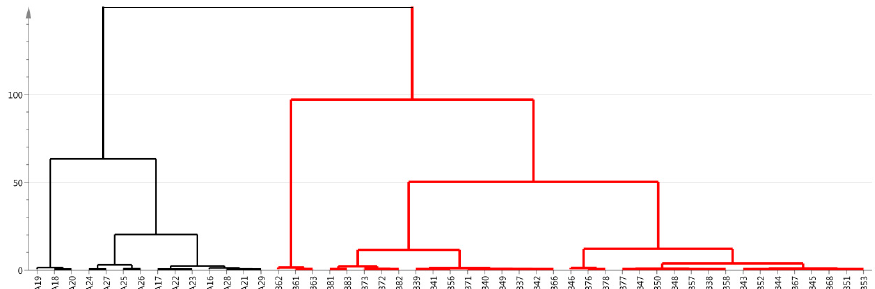
Figure 4. Results of hierarchical cluster analysis of samples.